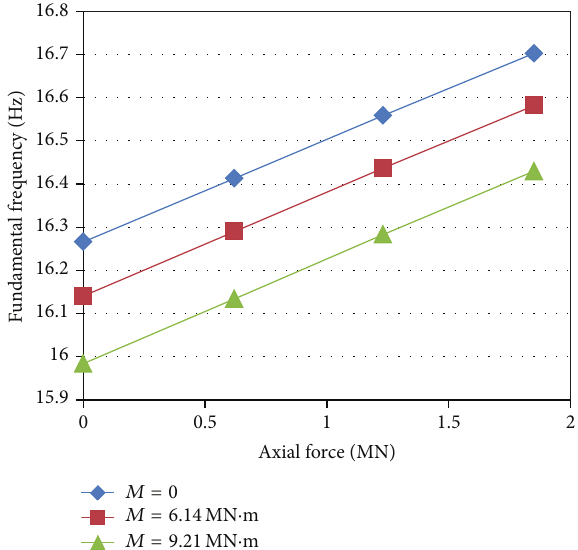
Figure 7: Variation of the fundamental frequency with tensile force and end moment; clamped-pinned (C-P) boundary condition.